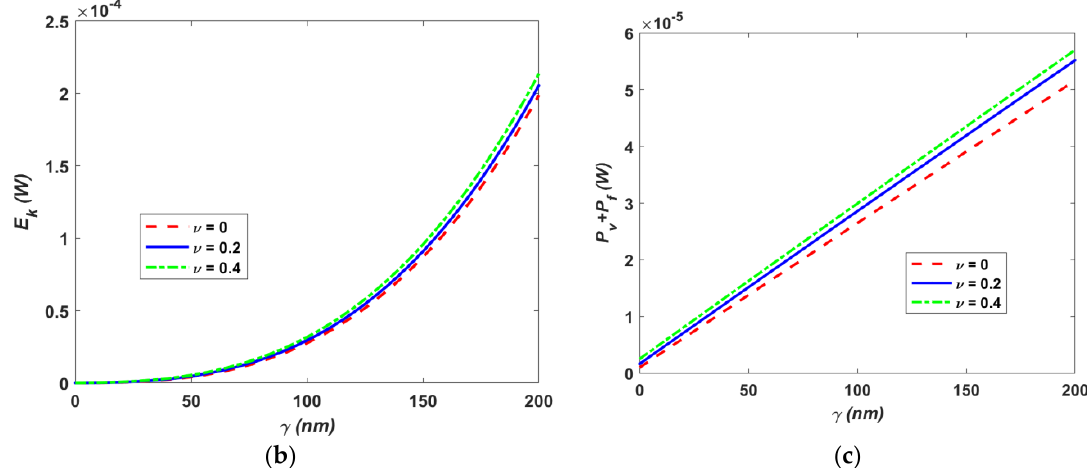
Figure 5. The variations of various energy items: ( a ) Joule heating effect P j * , ( b ) kinetic power E k * and ( c ) the sum of viscous dissipation P v * and frictional heating P f * for different steric factors ( ν = 0, 0.2, 0.4) when λ * = 7.5 nm, λ * FCL = 25 nm, µ c = 10 4 Pa s/(km) 2 and ω = 5.4 mC/m 2 .